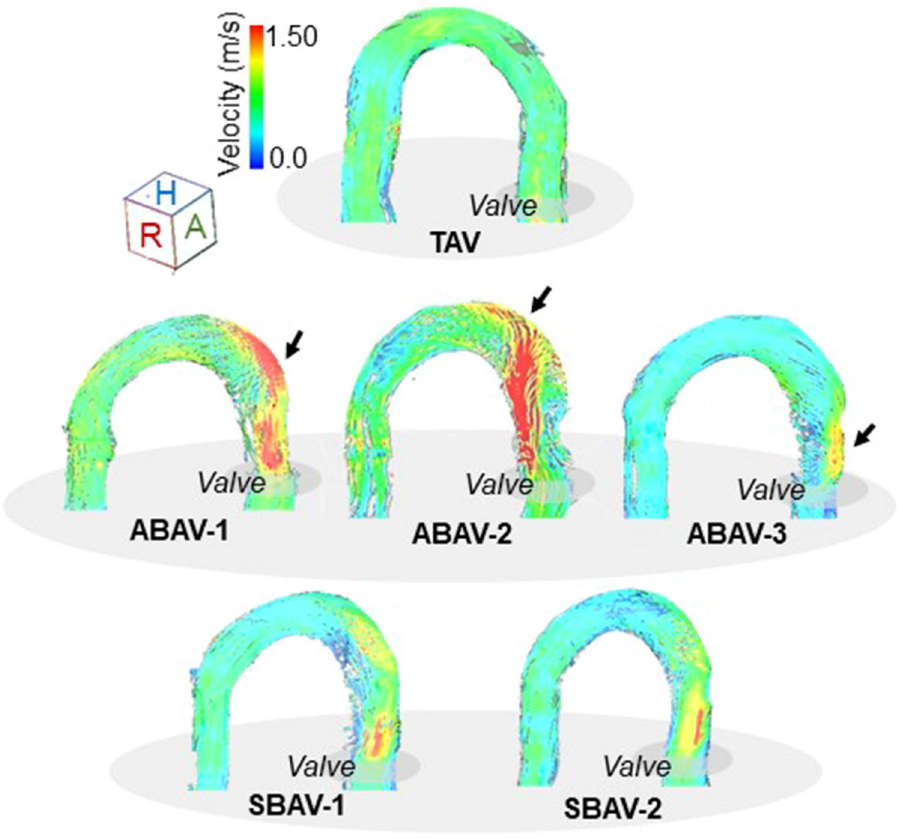
Figure 6. Streamlines of peak systolic aortic flow in the six valve morphologies. The tricuspid aortic valve (TAV) presents a laminar aortic flow. In the asymmetric bicuspid aortic valves (ABAVs), ABAV-1 morphology revealed eccentric aortic valvular outflow jet impinging on the outer curvature of the ascending aorta; ABAV-2 morphology revealed a long-traveling outflow jet impinging on the outer curvature of the proximal transverse arch; and ABAV-3 morphology revealed a short-traveling outflow jet impinging on the supra-valvular aortic wall. In symmetric BAVs, aortic valvular outflow jets do not impinge on the aortic wall. Arrows indicate the aortic wall locations where the aortic valvular outflow jet